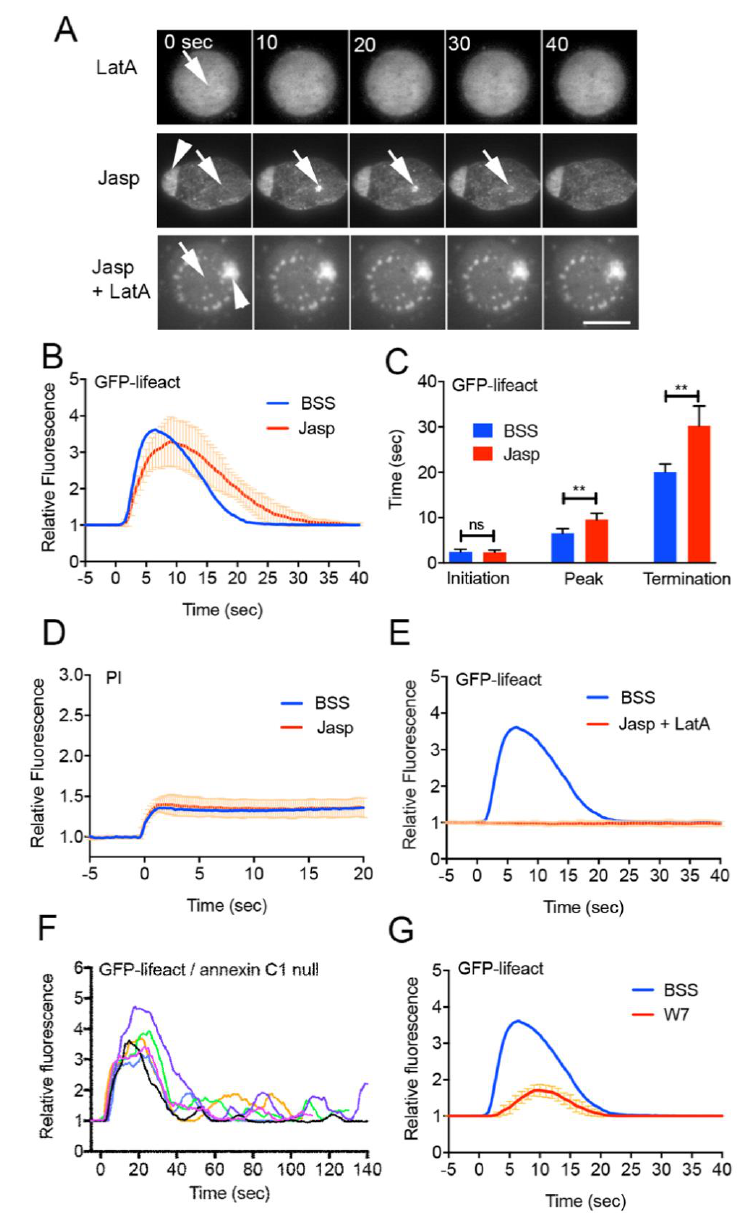
Figure 2. Actin polymerizes de novo at wound sites. ( A ) Typical sequences of fluorescence images of cells expressing GFP-lifeact in the presence of latrunculin A and/or jasplakinolide. Arrows and arrowheads show the wound sites and large actin aggregates, respectively. ( B ) Time courses of fluorescence intensities of GFP-lifeact at the wound site in the presence (Jasp) and absence (BSS) of jasplakinolide, respectively. Note that the time courses in the presence of latrunculin A are shown in Figure 1G. ( C ) The initiation, peak, and termination times of wound-induced actin accumulation are compared in the presence and absence of jasplakinolide ( n = 25 each). Data are presented as means ± SD. ** p ≤ 0.0001; ns : not significant, p > 0.05. ( D ) Time courses of PI influx in the presence and absence of jasplakinolide ( n = 25 each). ( E ) Time courses of fluorescence intensities of GFP-lifeact at the wound site in the presence and absence of both inhibitors (Jasp + LatA) ( n = 25 each). ( F ) Time courses of fluorescence intensities of GFP-lifeact at the wound site in annexin C1-null cells. The graphs with different colors show time courses of six different cells. ( G ) Time courses of fluorescence intensities of GFP-lifeact at the wound site in wild-type cells in the presence and absence of W7 ( n = 25